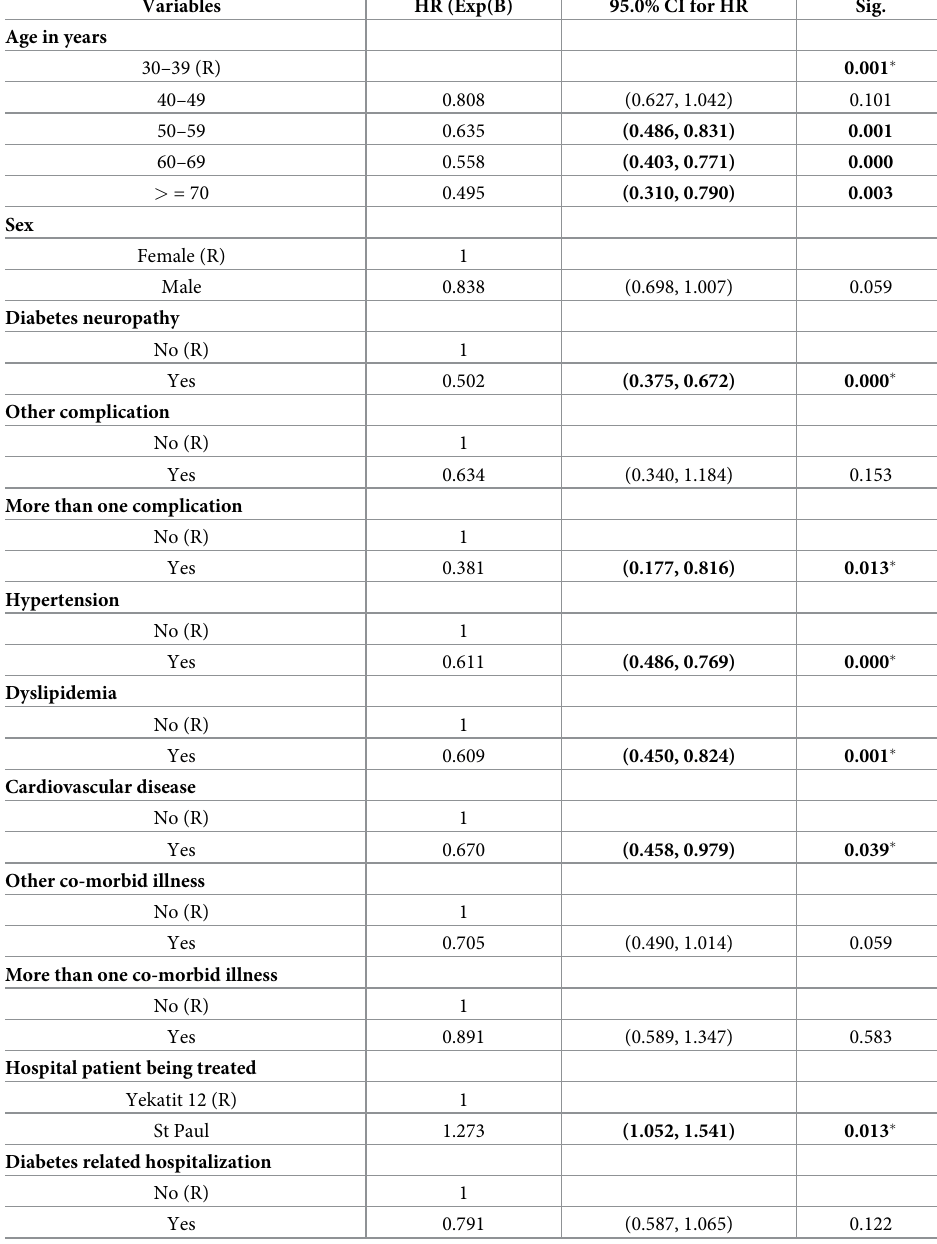
Table 5. Results for the final Cox proportional hazard model among T2DM patients,Addis Ababa, 2018(n = 685).